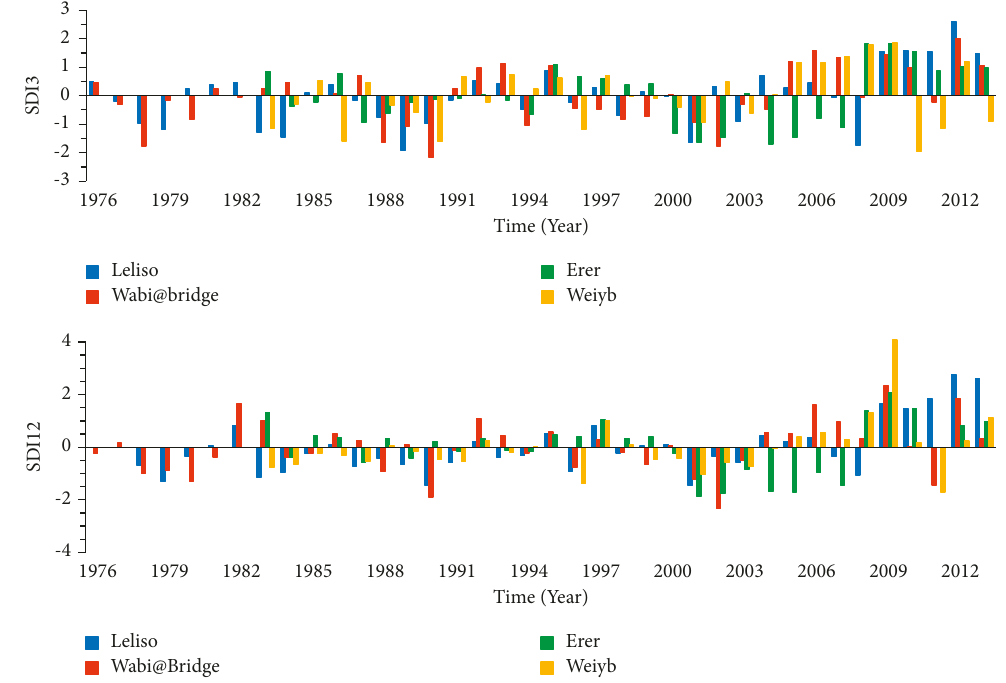
Figure 10: Temporal variation in seasonal (SDI3) and annual (SDI12) for the Wabishebele river